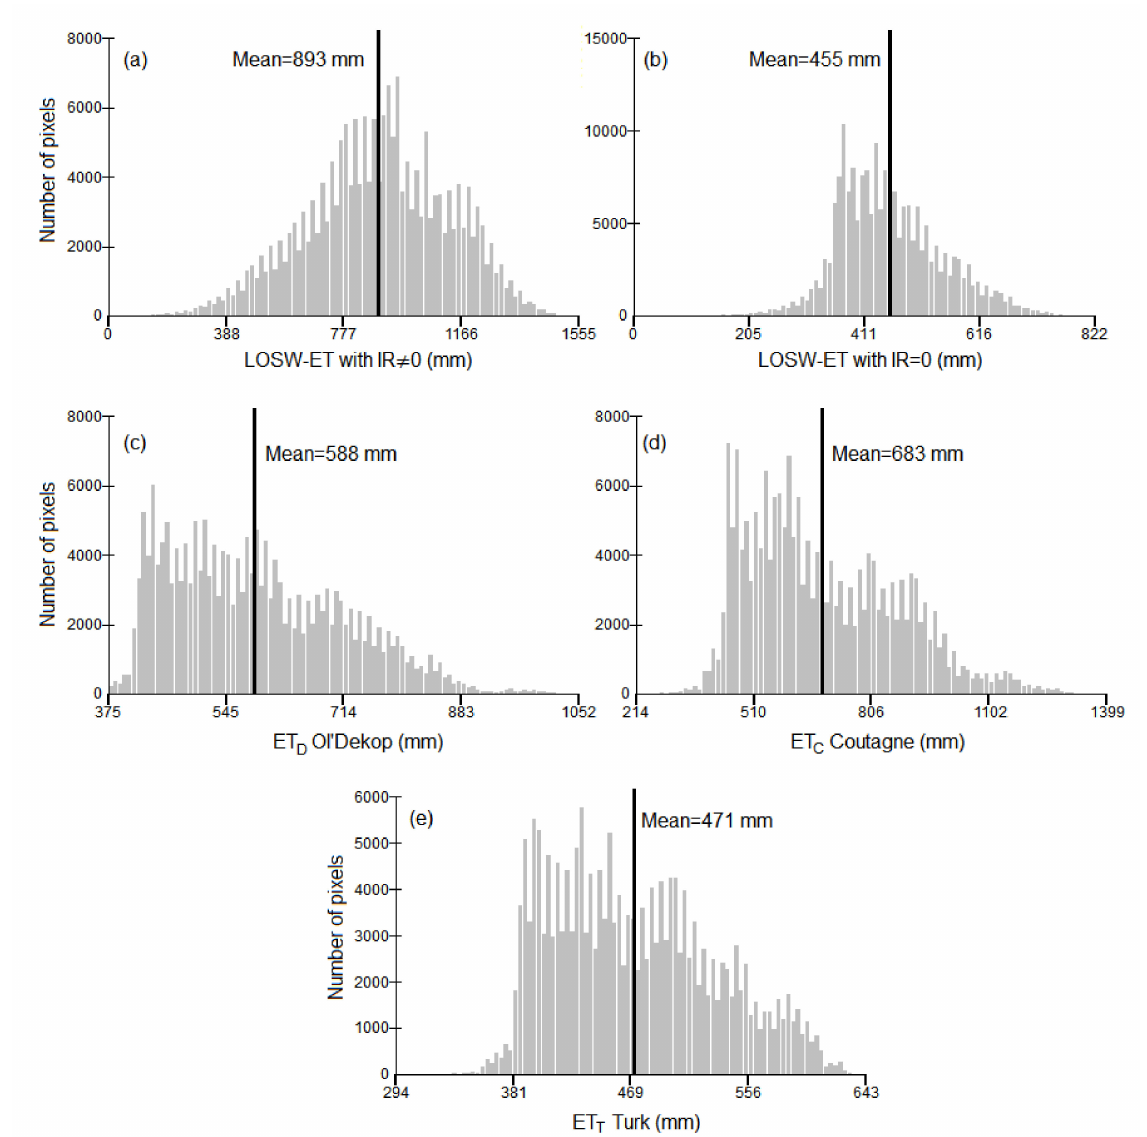
Figure 4. Frequency histograms of mean annual actual evapotranspiration of ( a ) LOSW-ET with IR (cid:54) = 0, ( b ) LOSW-ET with IR = 0, ( c ) ET D Oldekop, ( d ) ET C Coutagne, and ( e ) ET T Turk for the period 1950–2000 based on the pixel values of the respective raster datasets of Figure